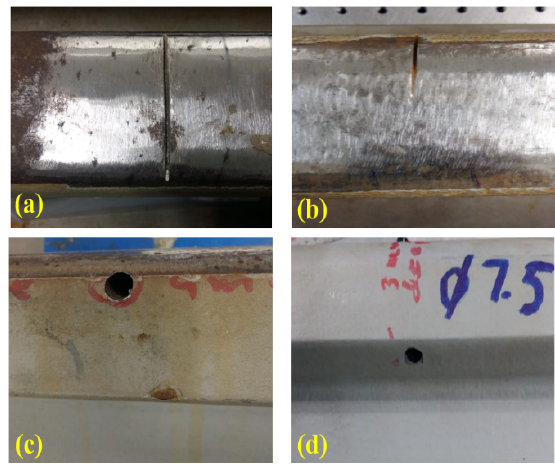
Figure 3. Real test specimens: ( a ) specimen B with surface horizontal defect; ( b ) specimen C with surface edge defect; ( c ) specimen D with subsurface horizontal defect; ( d ) specimen E with subsurface vertical defect.